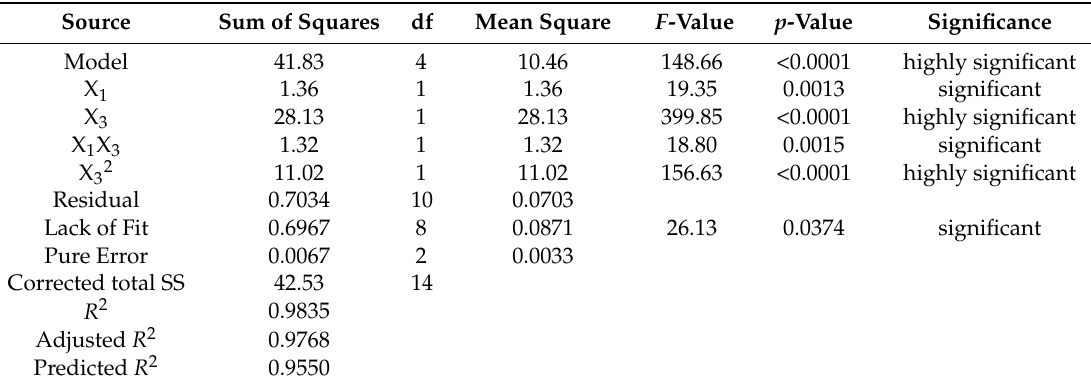
Table 5. ANOVA results for reduced model of the response variable R 1 .